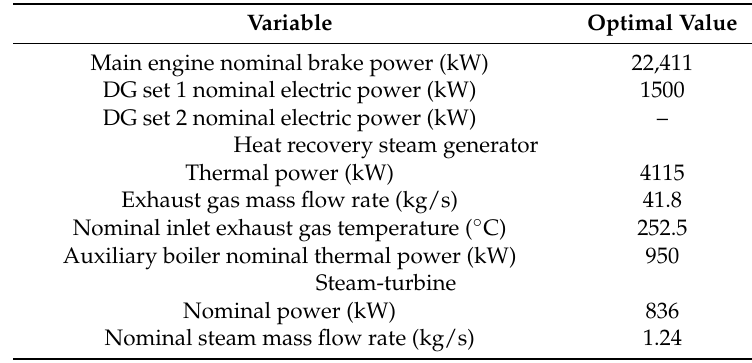
Table 27. Optimal design specifications of the system components.